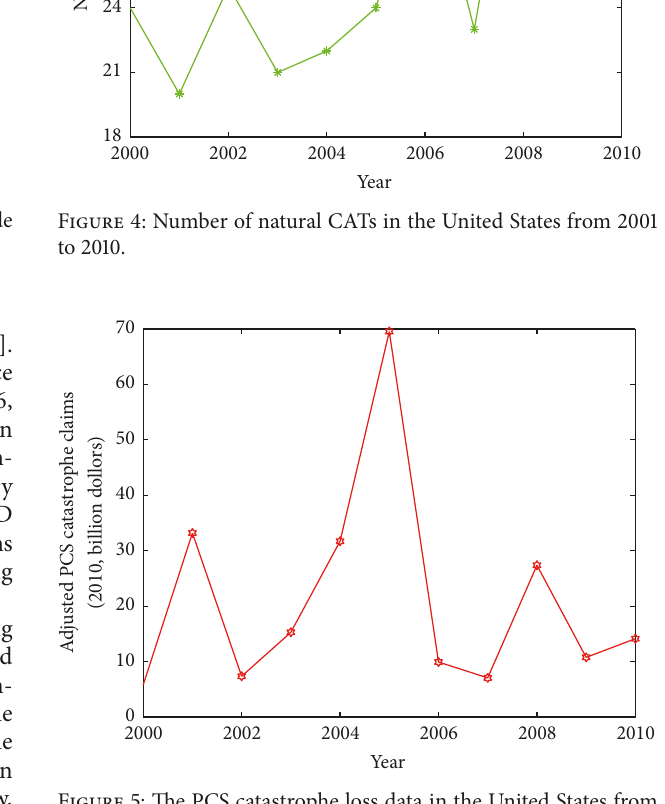
Figure 5: The PCS catastrophe loss data in the United States from 2001 to 2010 (USD billion, 2010